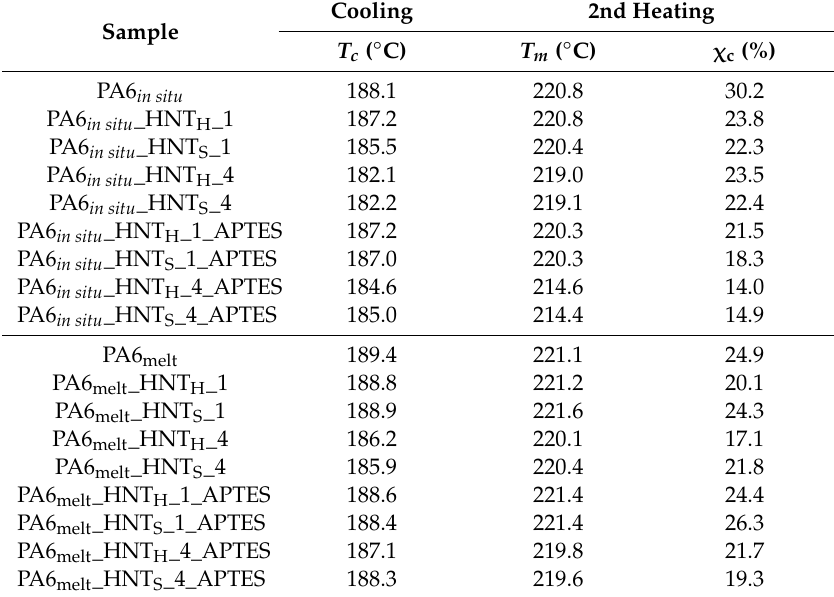
Table 3. DSC data of PA6-HNT nanocomposites collected during cooling and second heating thermal